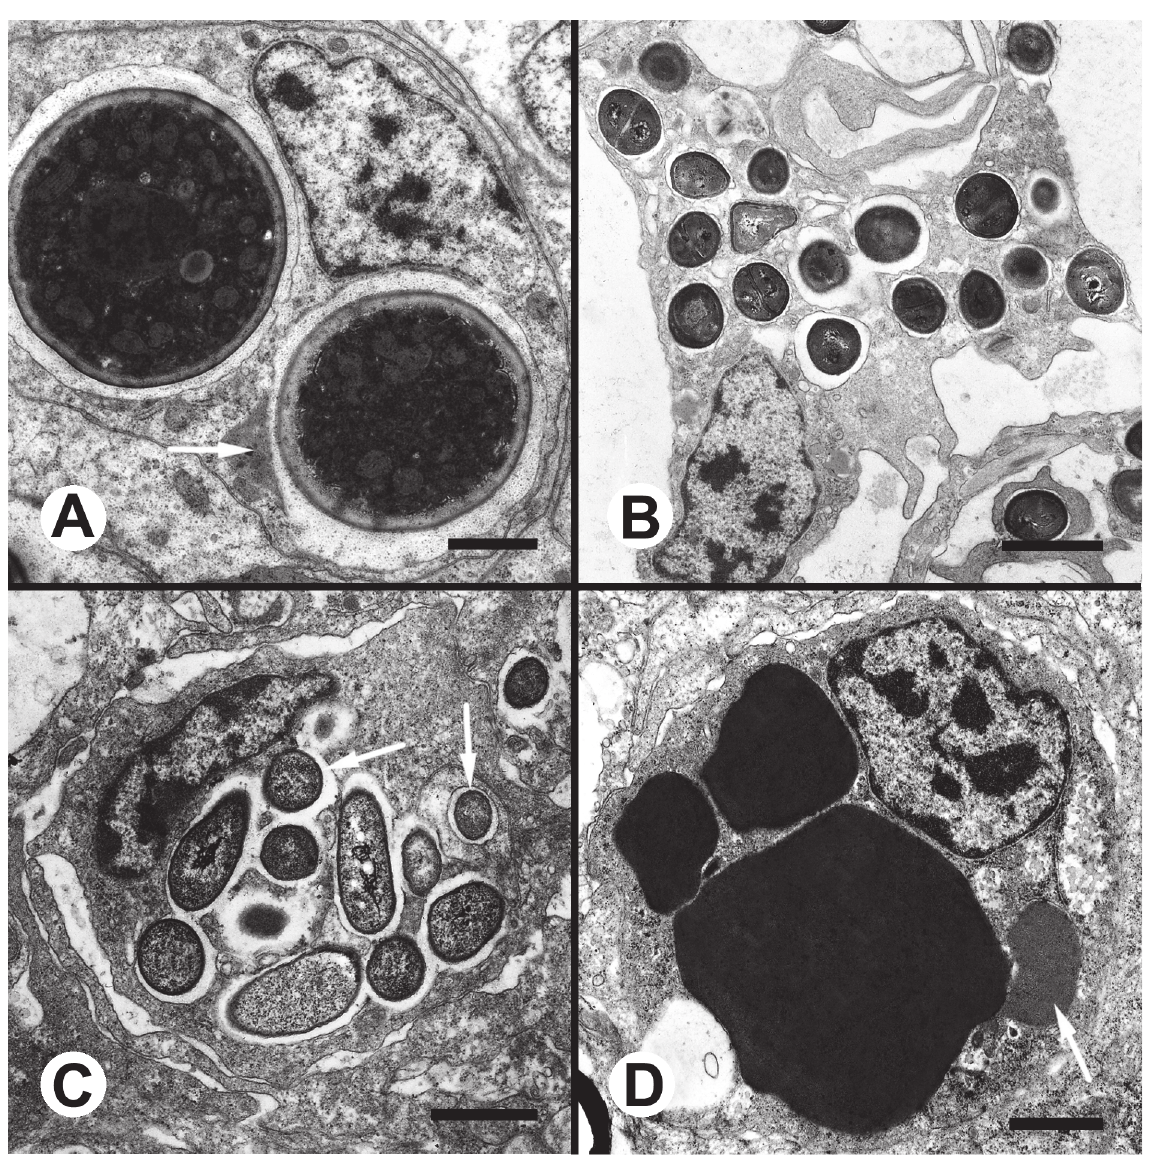
Fig 6. In vitro microbial phagocytosis by circulating hemocytes (TEM). (A) Two yeast cells engulfed by a phagocytic hemocyte; a large L granule is attached to one of the phagosomes and may be preceding fusion (arrow). (B) Numerous S . aureus cells engulfed by a hemocyte within seldom interconnected phagosomes. (C) E . coli cells may also be phagocytized in large numbers within complex phagosomes which frequently show more than one compartment (arrows). (D) Granulocyte in a preparation exposed to E . coli cells showing extensive R granule fusion and a single L